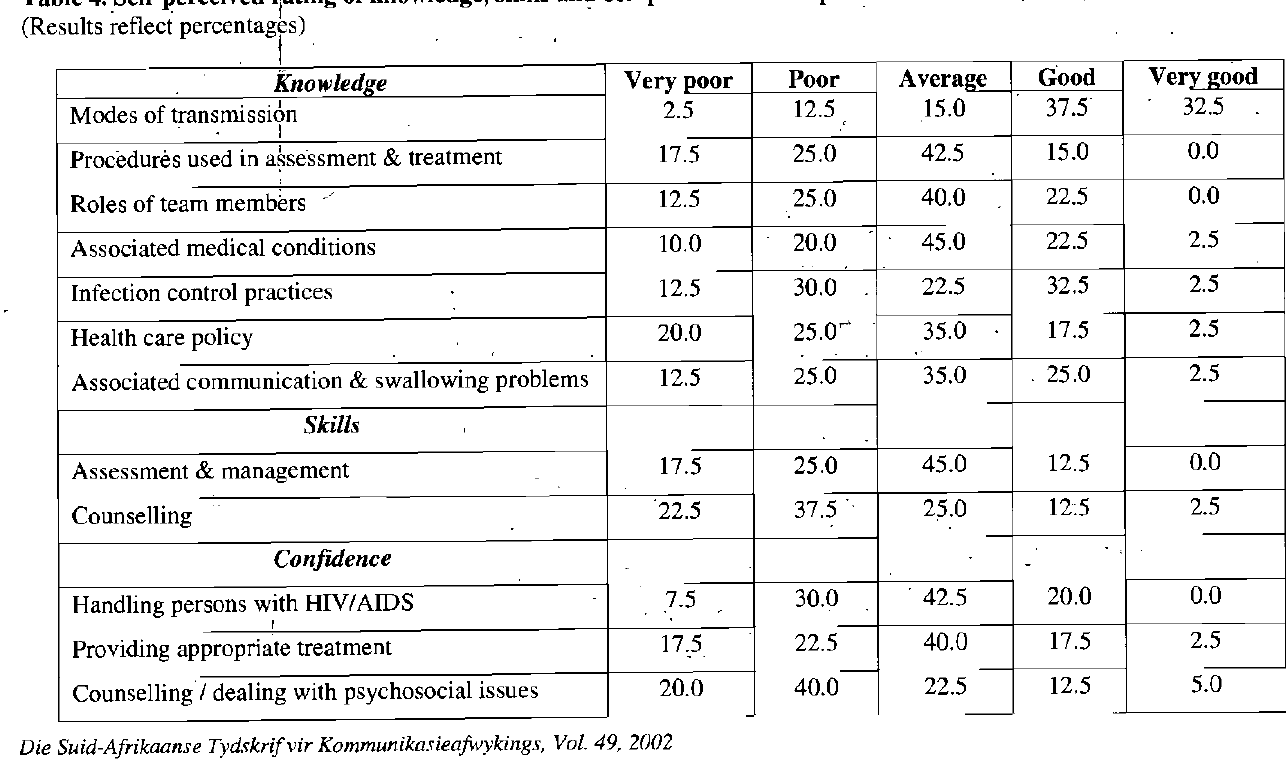
Table 4. Self-perceived rating of knowledge, skills and competence with respect to HTV/AIDS (N=40). (Results reflect